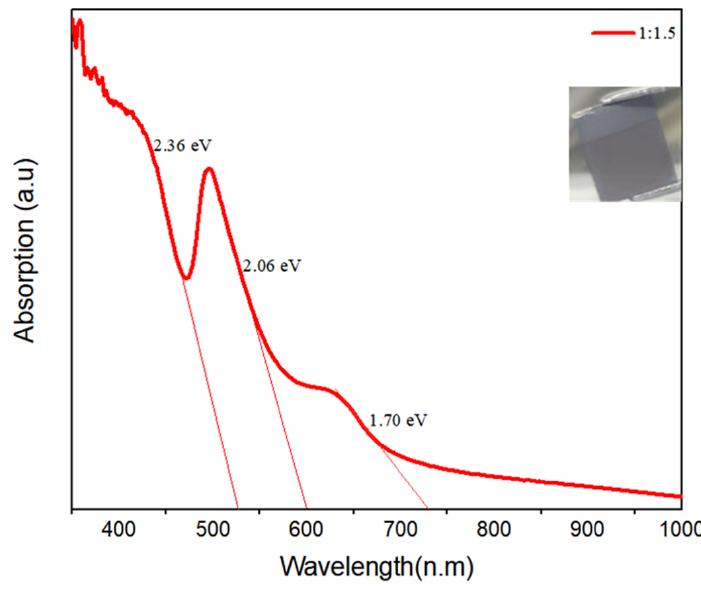
Figure 6. Absorption spectra for the caesium bismuth iodide fabricated at CsI/BiI 3 ratio of1/1.5.